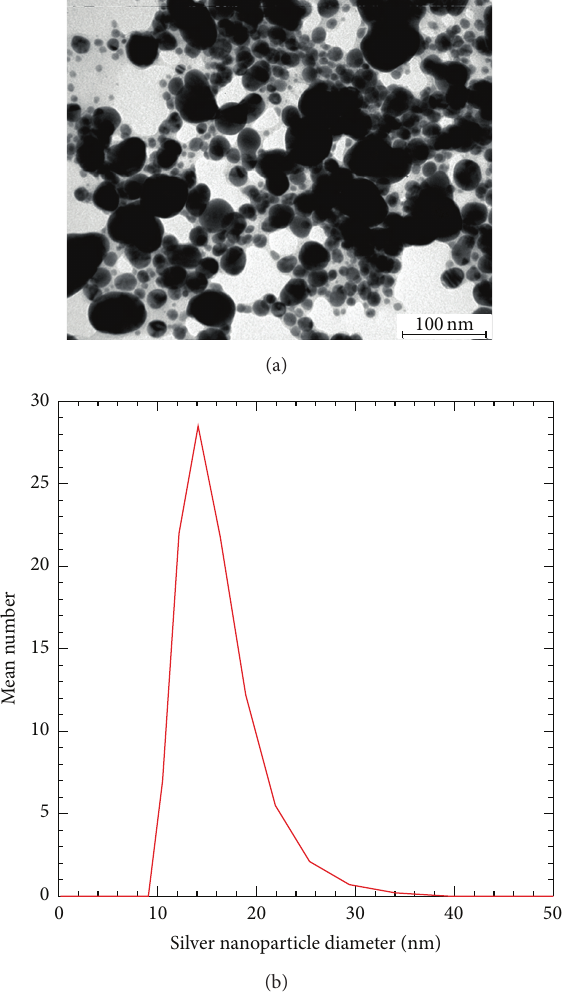
Figure 2: TEM micrograph (a) and the particle size distribution (b) of AgNPs synthesized using mulberry leaf